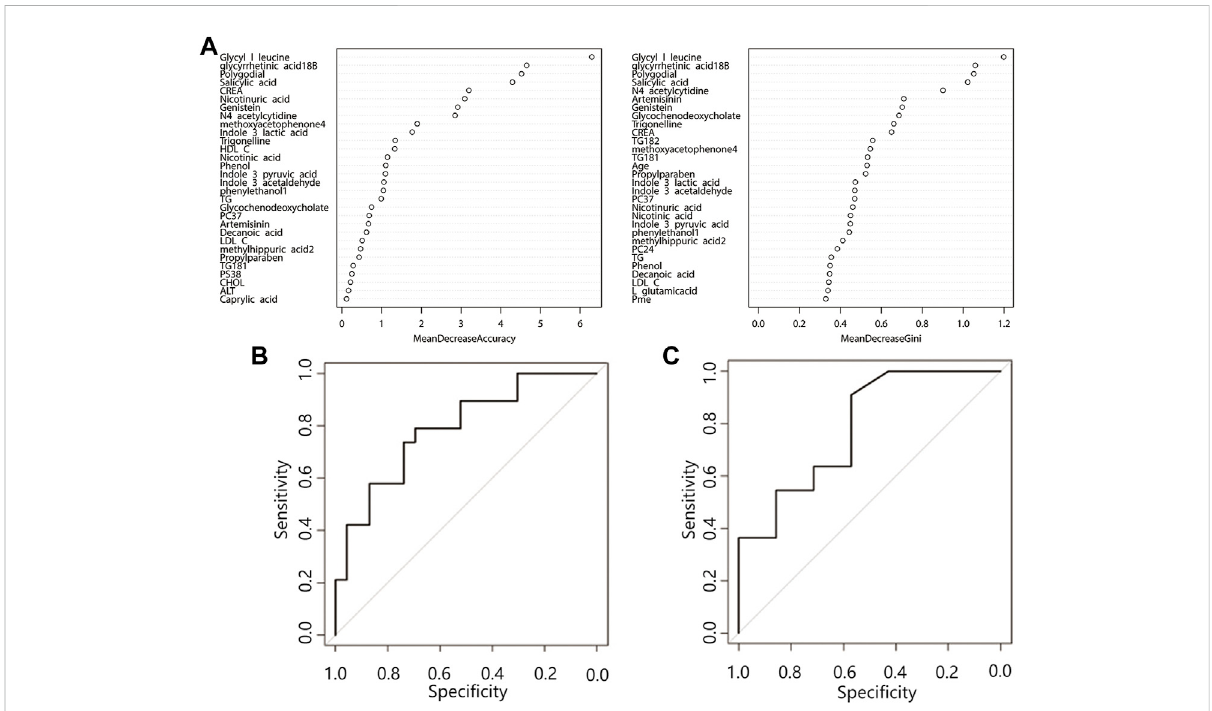
FIGURE 3 Random forest prediction model. (A) Top 30 important variables. The ordinate is each variable, and the abscissa is the mean decrease accuracy andthemeandecreaseGinivalue.Thelargerthevalueis,themoreimportantthevariableis. (B) TrainingsetROCcurve, (C) ValidationsetROCcurve. Abbreviations: CREA, creatinine; HDL C, high-density lipoprotein; TG, triglyceride; LDL C, low-density lipoprotein; CHOL, cholesterol; ALT, alanine aminotransferase; PC, phosphatidylcholine; PS,